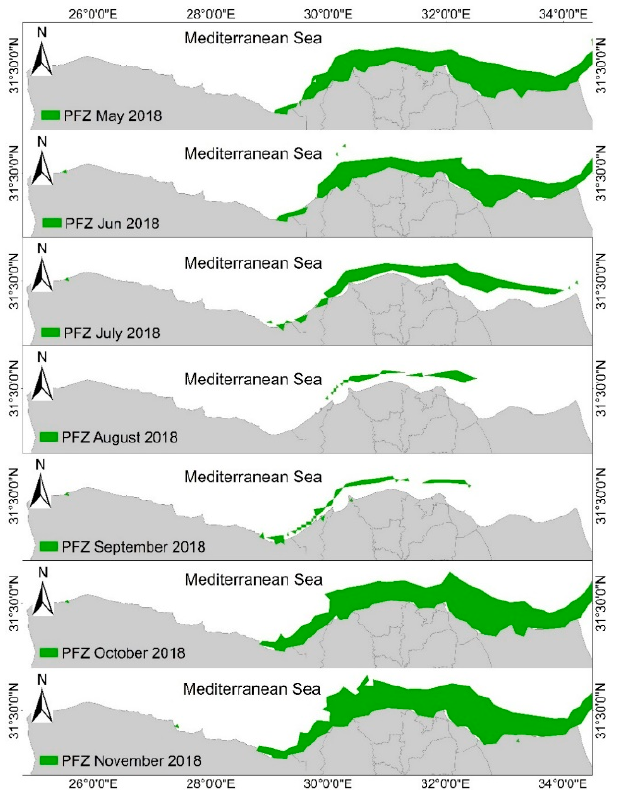
Figure 6. The monthly detected Potential Fishing Zones for Sardinella aurita over 2018 (May–November).